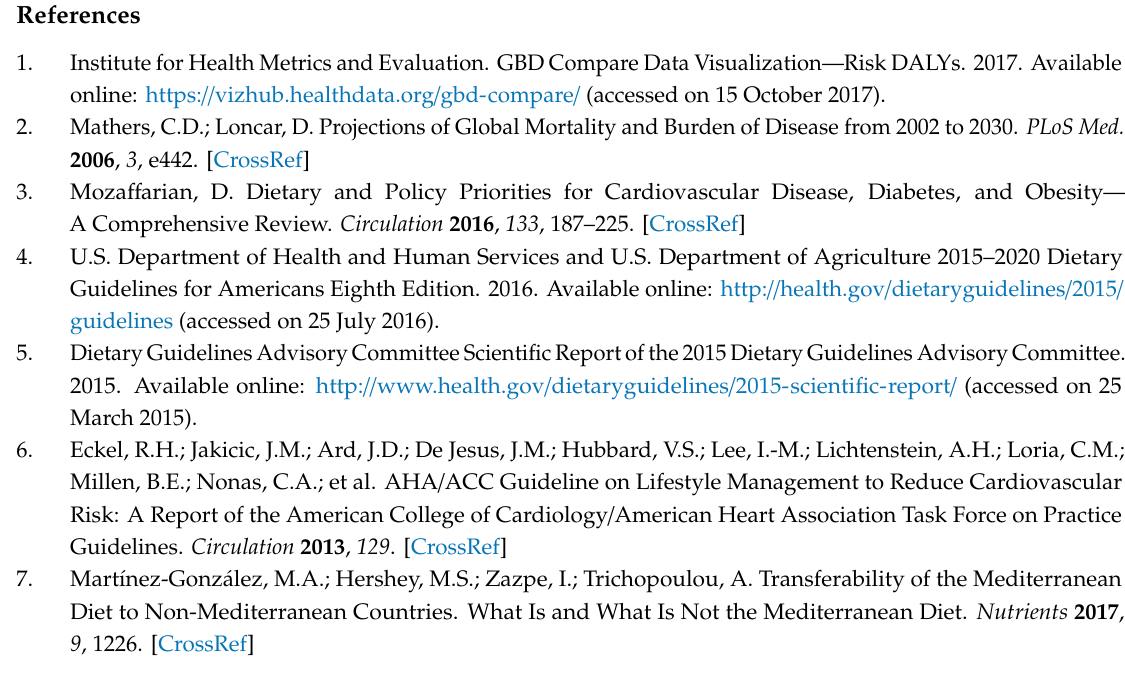
Table S1: Adjusted odds ratio (AOR) for tertile 3 (T3) vs. tertile 1 (T1) DP comparisons for selected